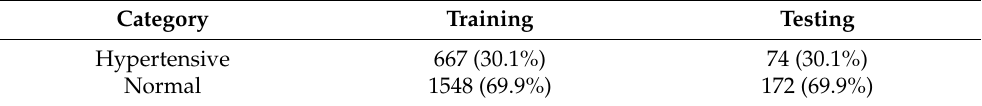
Table 2. Distribution of hypertensive and normal participants in the training and testing dataset.